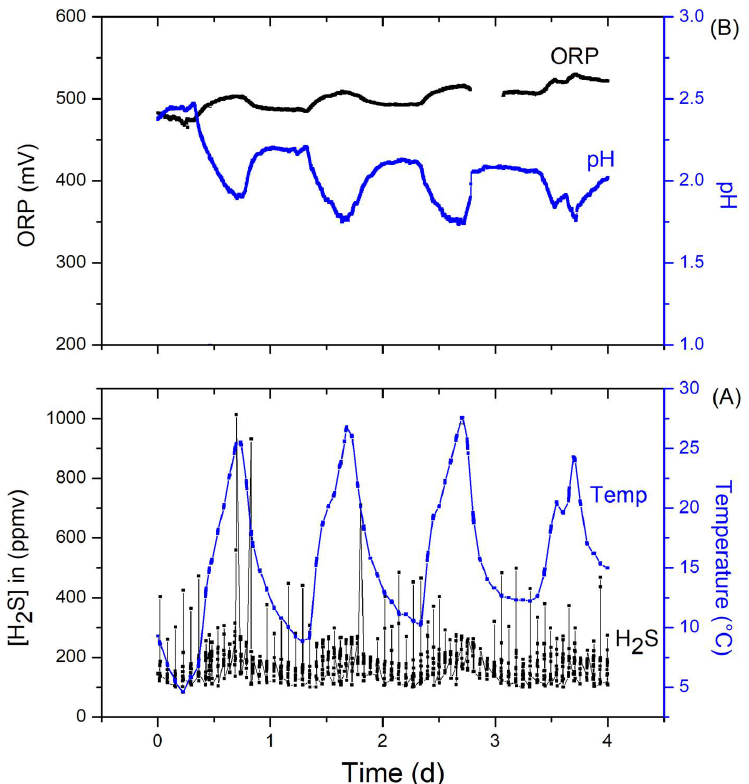
) and removal e ffi ciency ( (cid:8) ). (cid:35)